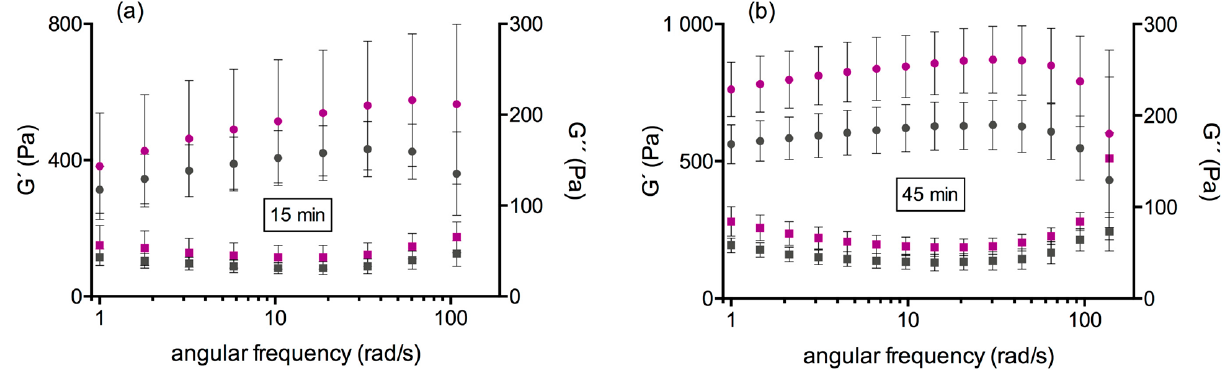
Figure 2. SEM of fully formed human and rat blood clots at 15,000× magnification. Rat fibrin fibers are thinner and more contorted, even if they bind to RBCs, and the fiber meshwork is denser. Note that the human RBCs are species-specifically larger.